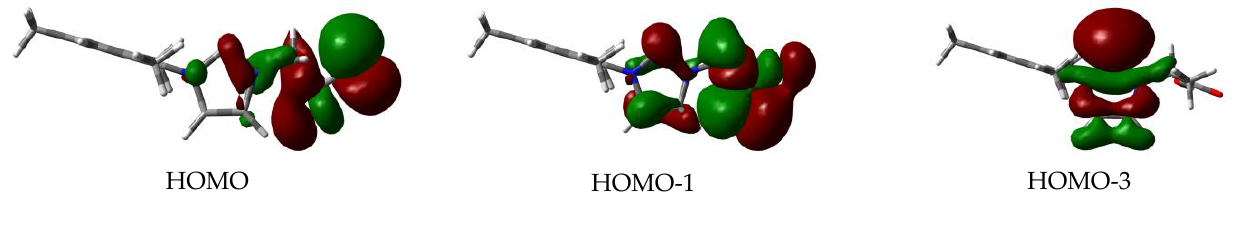
Figure 4. Selected MOs of [NHC Mes,H ] − ligand.